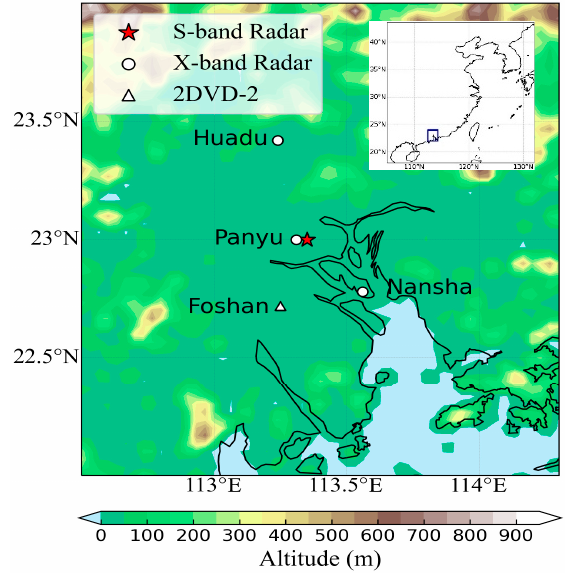
Figure 1. Location of X-band dual-polarization phased array radar and S-band dual-polarization radar at Guangzhou on the digital terrain elevation map.